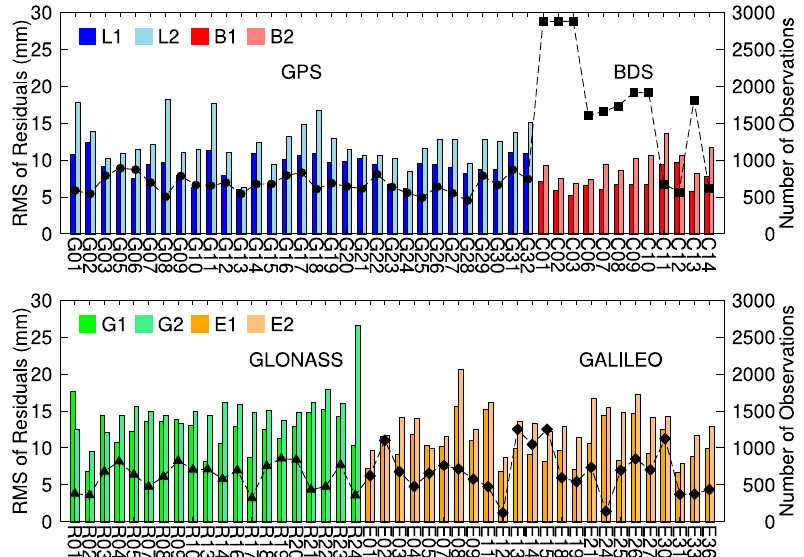
Figure 5. The posteriori residual RMS and the observation number statistics of GNSS satellites for PERT-CUT0 after solving with L1+L2 observations on DOY 88.